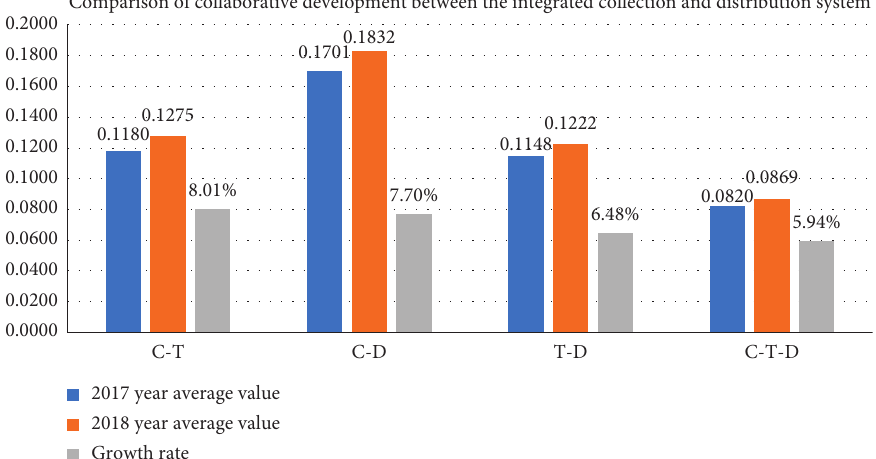
Figure 6: Comparison of the collaborative development between the integrated collection and distribution